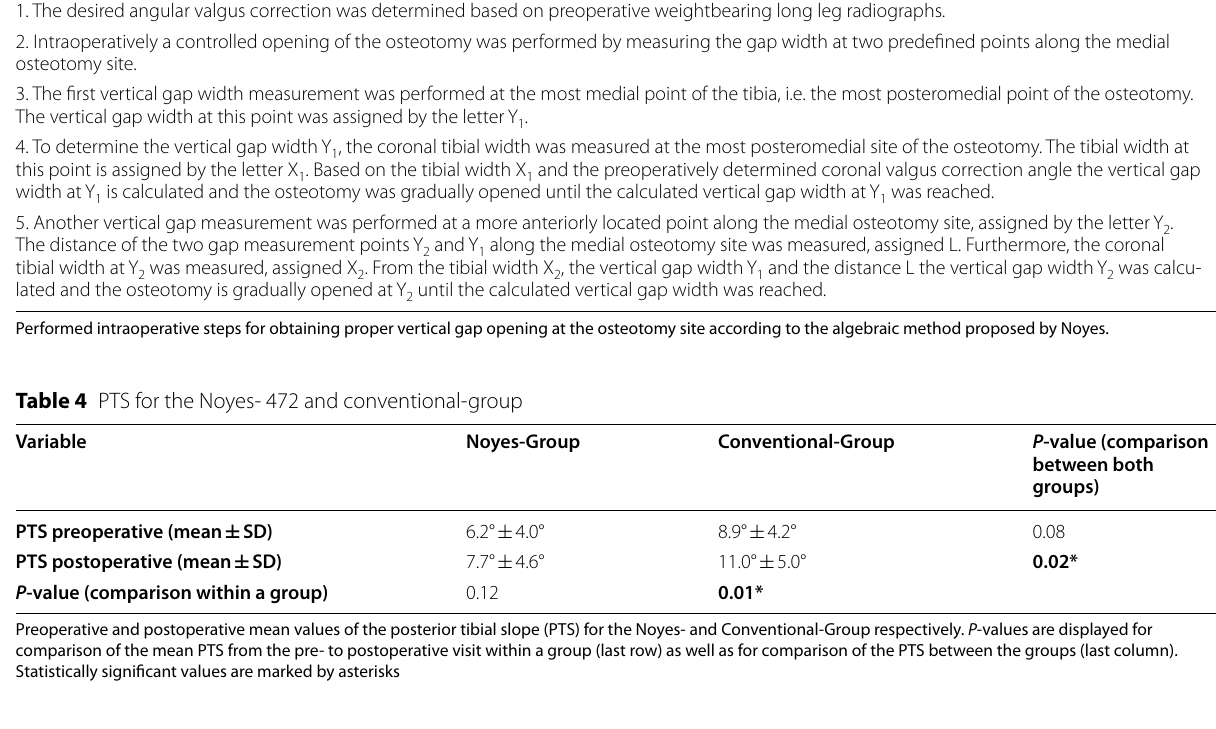
Table 5 Location of the WBL for the Noyes- and Conventional-Group